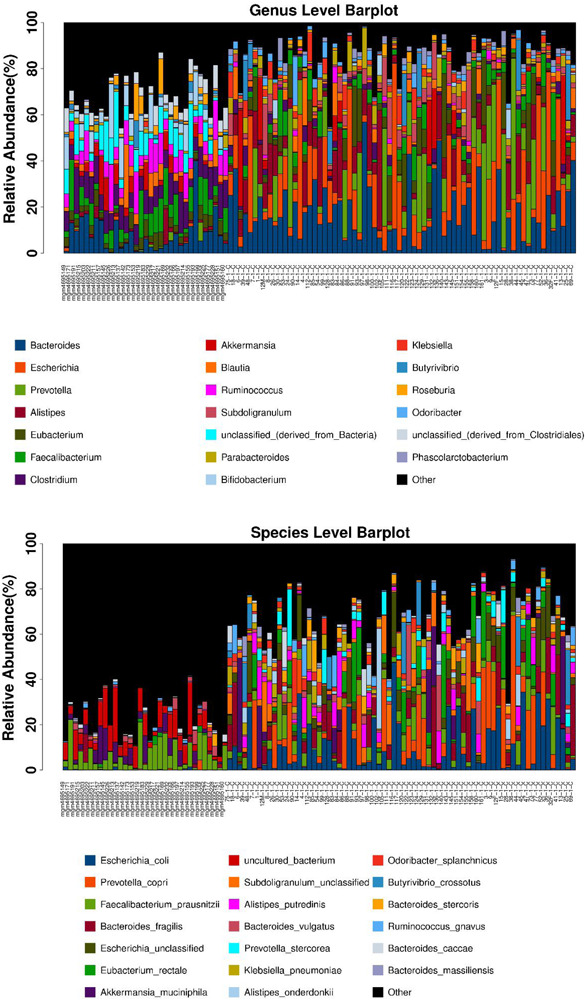
The microbial composition at the genus and species level of each samples are shown as barplot. The horizontal axis is the sample name, the vertical axis is the relative abundance ratio of genera/species. At the bottom of the barplot, the different color boxes represent different genera/species, among them the black box named other represents the sum of genera/species other than the top 20.